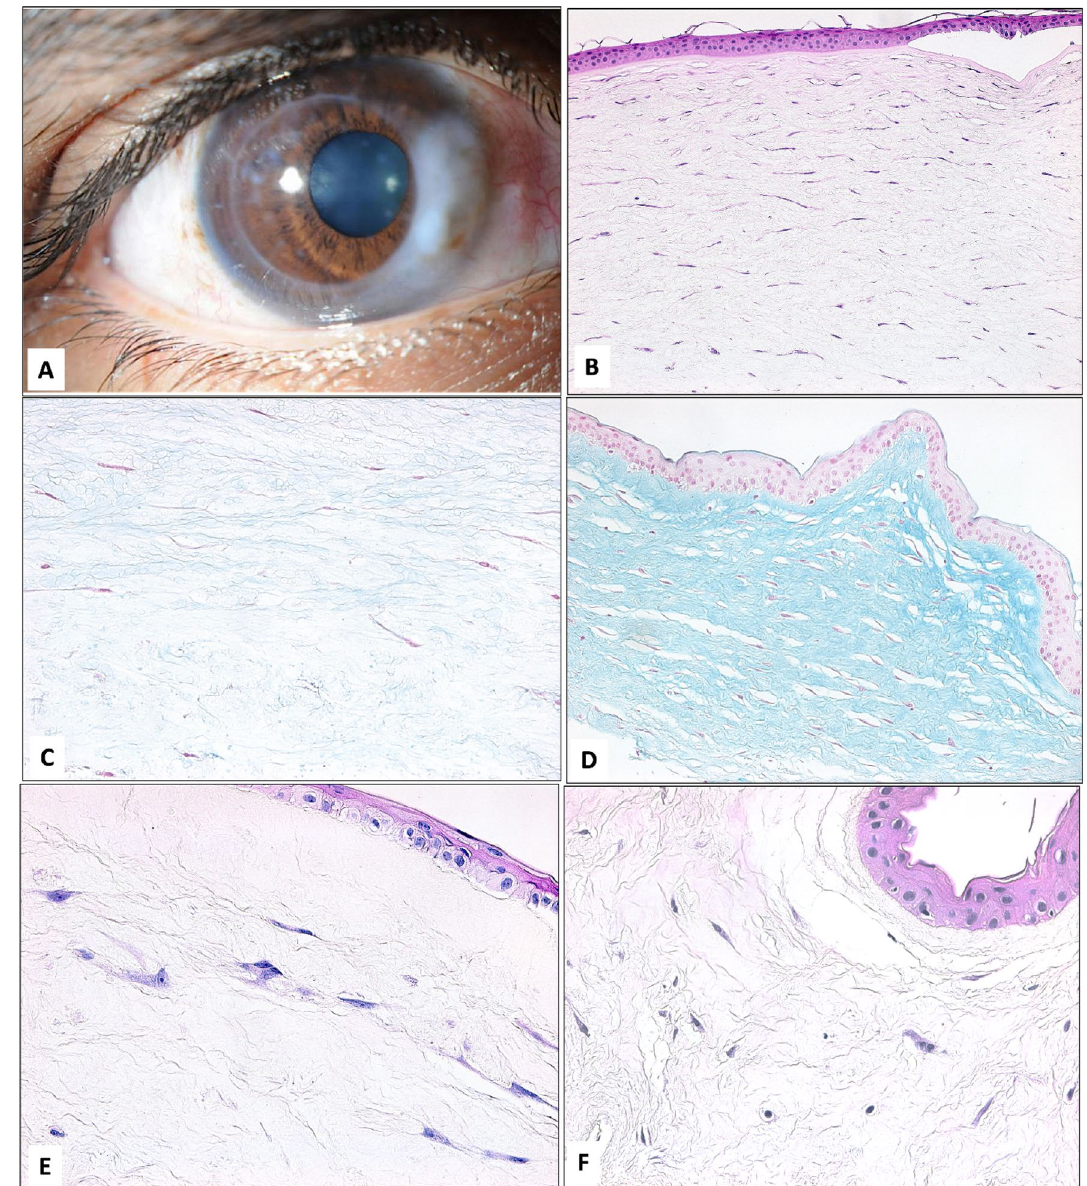
recipient’s corneal rim adjacent to the corneal graft edge nasally. ( B ) The histopathological appearance of the corneal myxoma is composed of stellate and spindle-shaped cells anteriorly with thin corneal epithelium, bullae, and absent Bowman’s layer. Note the hypocellularity of the myxoma in this secondary type (× 200 magnification, Hematoxylin and Eosin). ( C ) Weak Alcian blue staining (< grade 1) in the same keratoconus case representing secondary-truly acquired-corneal myxoma (× 400 magnification). ( D ) Intense staining of Alcian blue (grade 3) of the primary myxoma in case 5 (× 200 magnification). ( E,F ) The histopathological appearance of